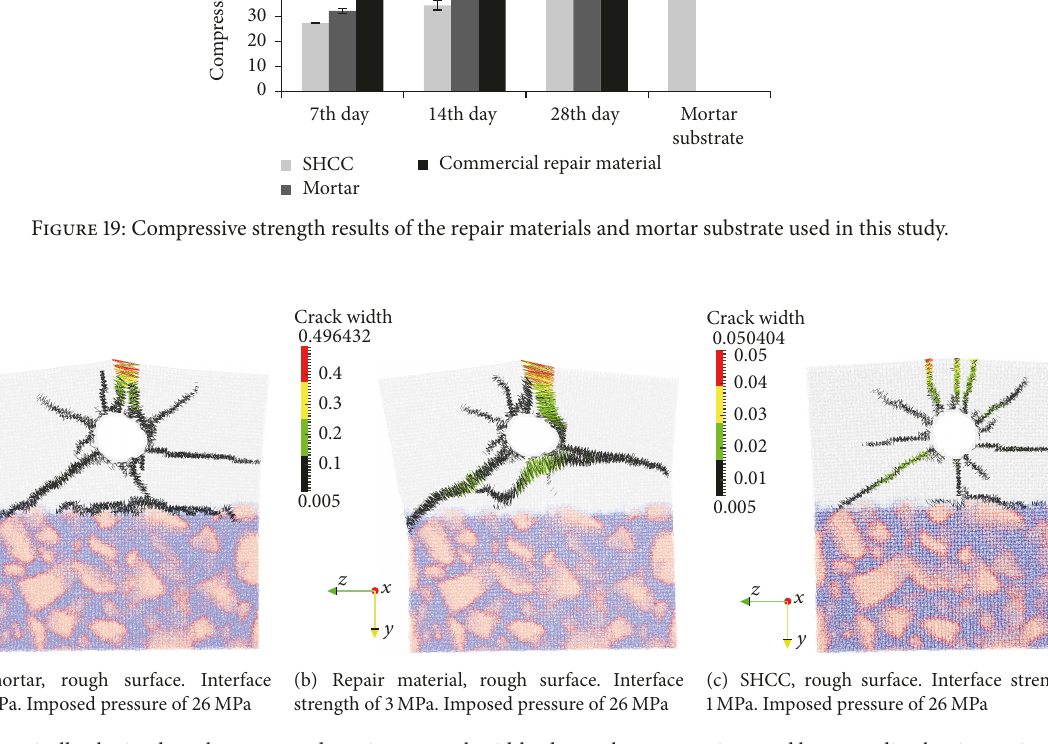
Figure 20: Numerically obtained crack pattern and maximum crack widths due to the pressure imposed by expanding bar in repair systems. Substrate is stronger than repair material, influence of the interface strength, and type of the repair material; top: repair material; bottom: substrate (deformation scaled 20x; note that for different samples maximum crack widths are